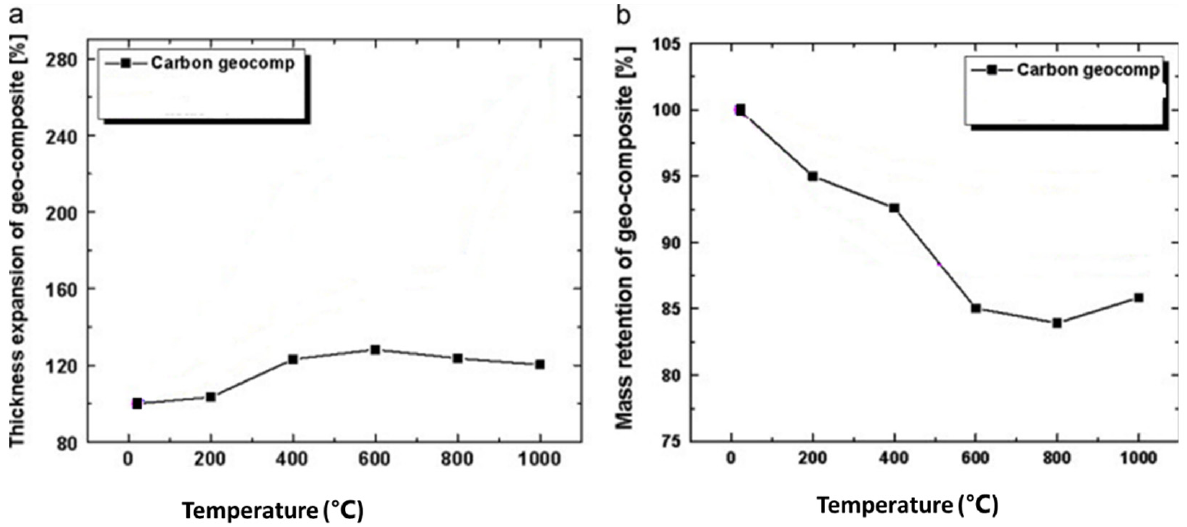
Figure 6. ( a ) Thickness expansion, and ( b ) mass retention of carbon fiber reinforced geopolymer composite as the function of annealed temperature.